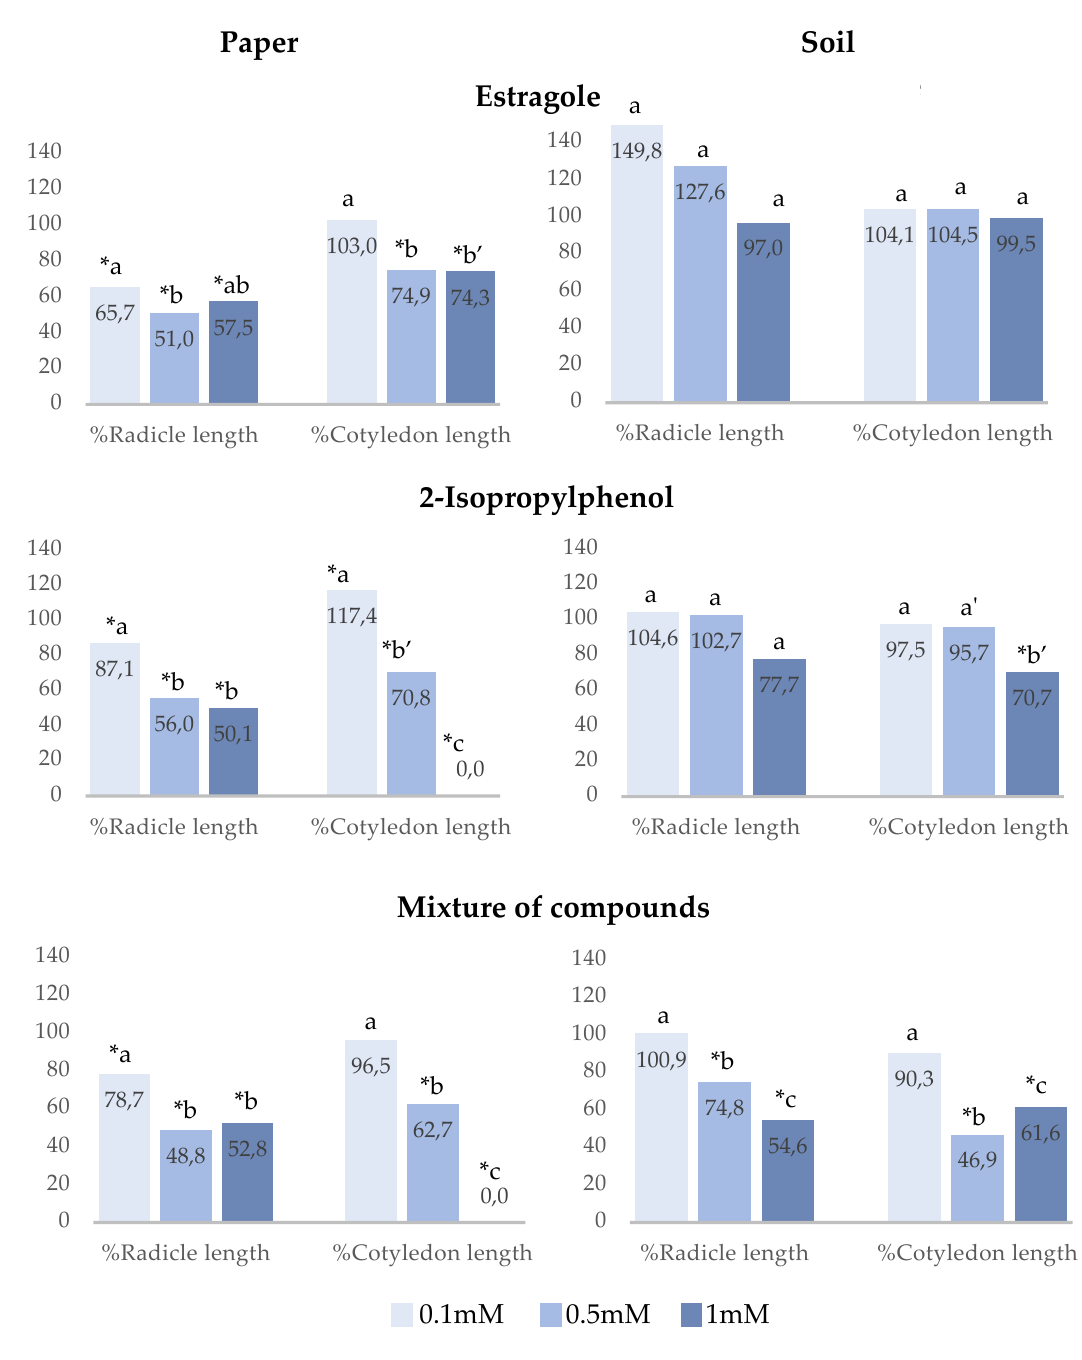
Figure 3. Effect of different concentrations of Estragole and 2-Isopropylphenol on the radicle and hypocotyl length of Allium cepa , expressed as the percentage relative to the control. Four replicates of each treatment were performed ( n = 4 × 50 = 200 seeds in total for each solution). * Significantly different from the controls. ’ Significantly different from the mixture of compounds. a, b, c: differences in small letters indicate significant differences between concentrations of the same index and for each treatment. p < 0.05 (Mann–Whitney